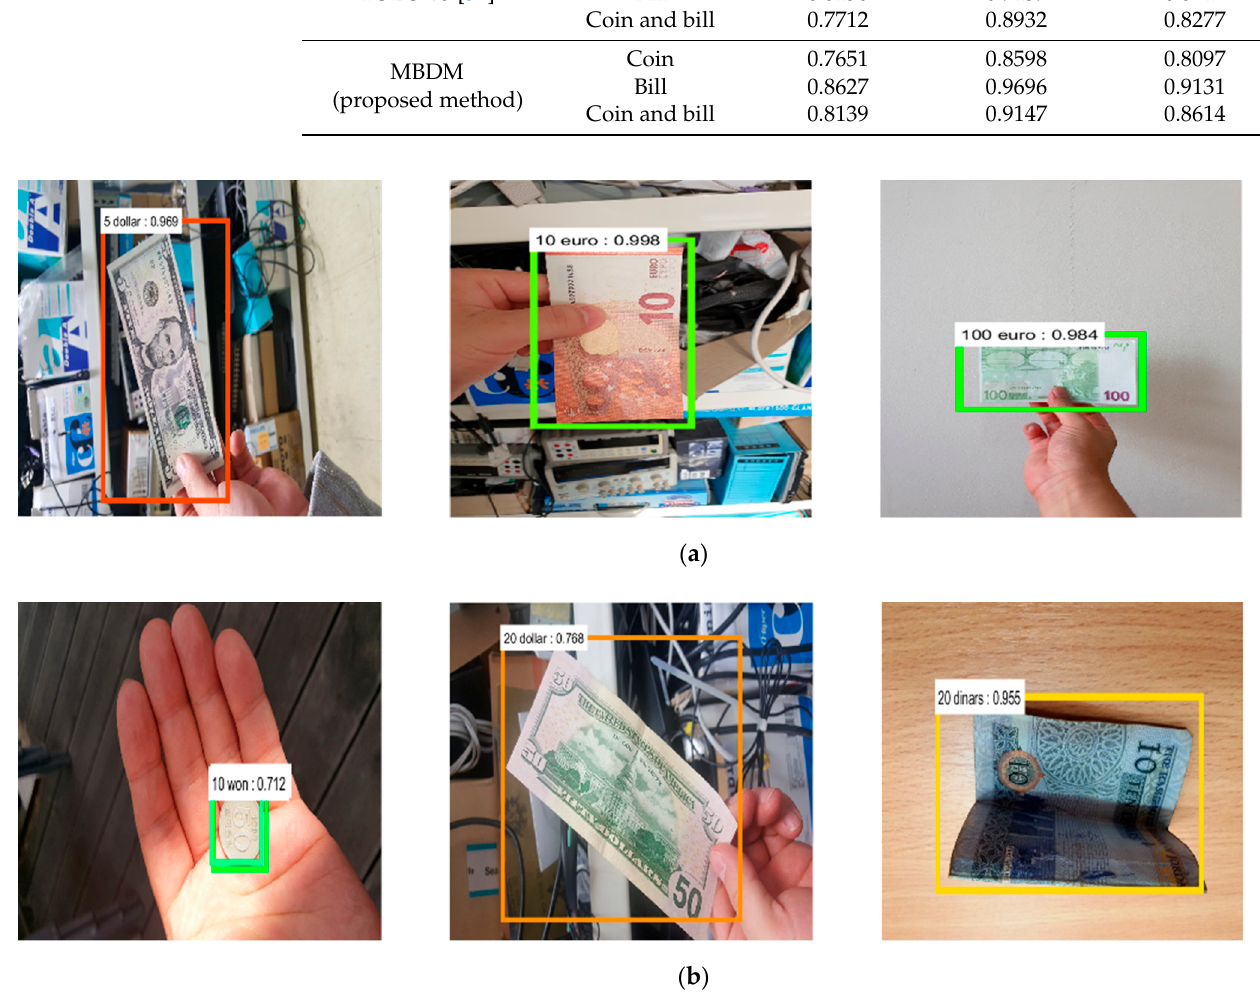
Figure 12. The detection results of the proposed method: ( a ) is the case where the detection was successful, and ( b ) is the case where the detection error occurred.